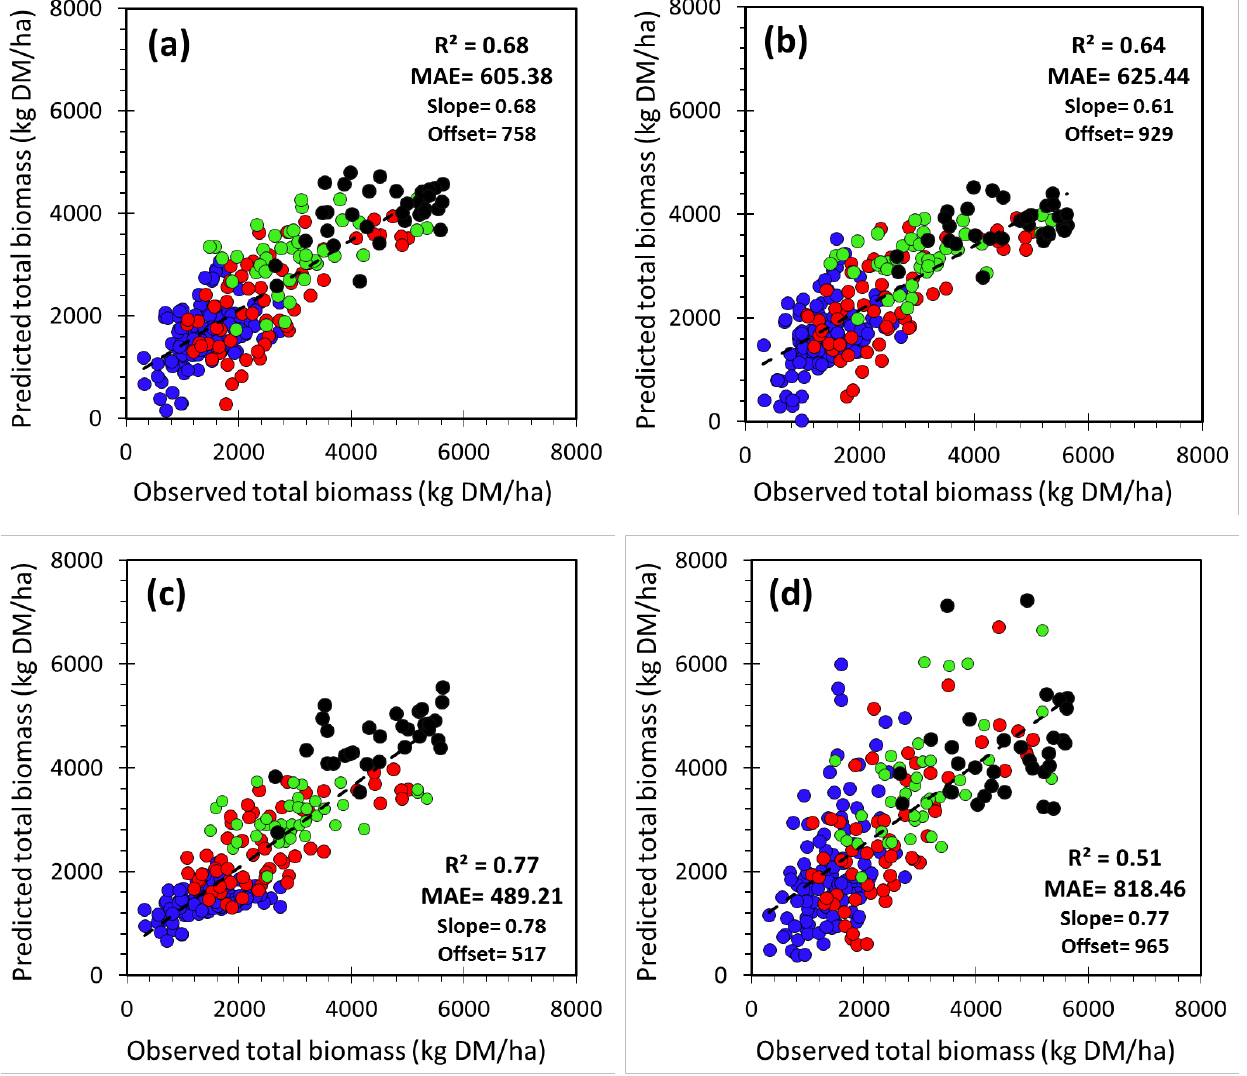
Figure 5. Relationships between observed and predicted total biomass by ( a ) Model_SA, ( b ) Model_EW, ( c ) ecoregion models, and ( d ) CSE biomass product. Evaluation over the same validation dataset ( n = 247 samples) from 2000 to 2013. The given statistics are the coefficient of determination (R 2 ), the mean absolute error (MAE, kg·DM/ha), and the slope and offset of the linear regression equation. For color correspondence, see Figure